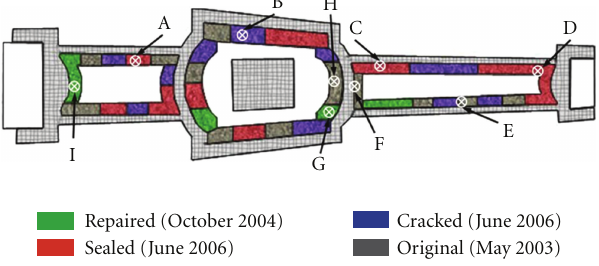
Figure 2: April 2011 core sample locations and delineation of physical conditions of concrete. Note: during the April 2011 inspection, all pervious concrete areas were found to be completely